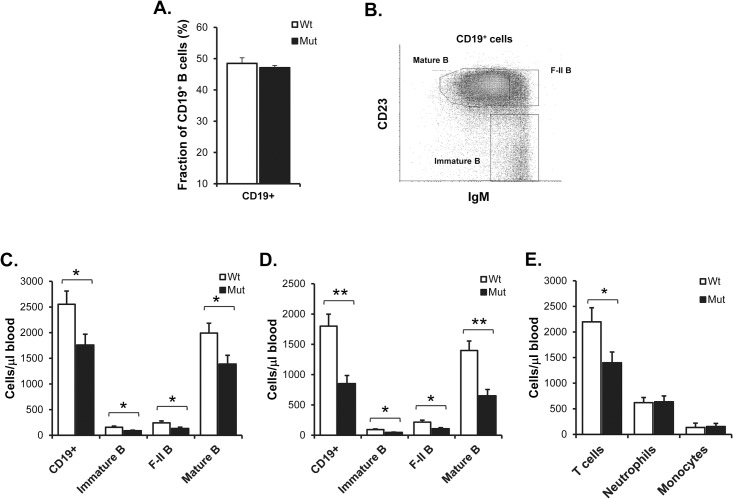
Lack of SIRPα signaling in vivo results in reduced numbers of blood B cells.(A) Fraction of CD19+ blood B cells in 12 weeks old wild-type (Wt–open bars) or SIRPα-mutant mice (Mut–black bars). (B) CD19+ blood B cell subsets were separated based on their expression levels of sIgM and CD23 to identify sIgMhiCD23-/lo immature B cells (Immature B), sIgMhiCD23hi semi-mature/follicular type-II (F-II B) B cells and sIgMlo/intCD23hi mature/F-I (Mature B) B cells. Data shown are the numbers of total CD19+, immature, F-II, or mature B cells per microliter of blood in wild-type (Wt–open bars) or SIRPα-mutant mice (Mut–black bars) at (C) 12 weeks or (D) 20 weeks of age. Data are means±SEM for 9 mice/group at 12 weeks and 4–7 mice/group at 20 weeks of age. (E) Absolute numbers of CD4/8+ T cells, CD11bhi Gr1hi neutrophils and CD11bhi Gr1low monocytes per microliter of blood in 16 weeks old wild-type (Wt–open bars) or SIRPα-mutant mice (Mut–black bars). Data are means±SEM for 5 mice/group. *P<0.05 and **P<0.01, as compared with that in wild-type mice, using Student’s t-test for unpaired analyses.